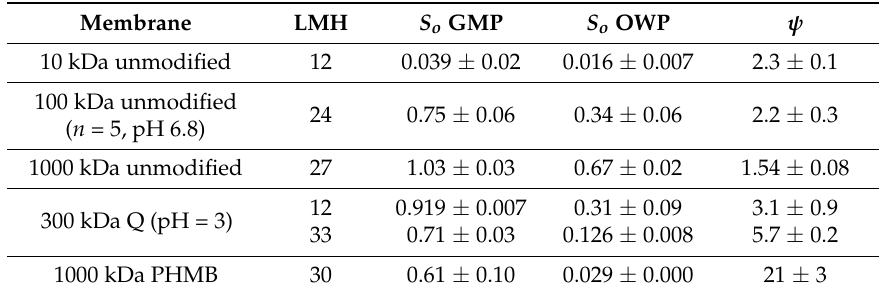
Table 1. Sieving coefficient ( S o ) of glycomacropeptide (GMP) and other whey proteins (OWP), and selectivity ( ψ ) measured using different ultrafiltration membranes. Experiments performed at pH 3.5 and 22 ◦ C and the natural conductivity of whey unless mentioned otherwise. Values are average ± 95% CI for duplicate experiments unless mentioned otherwise.